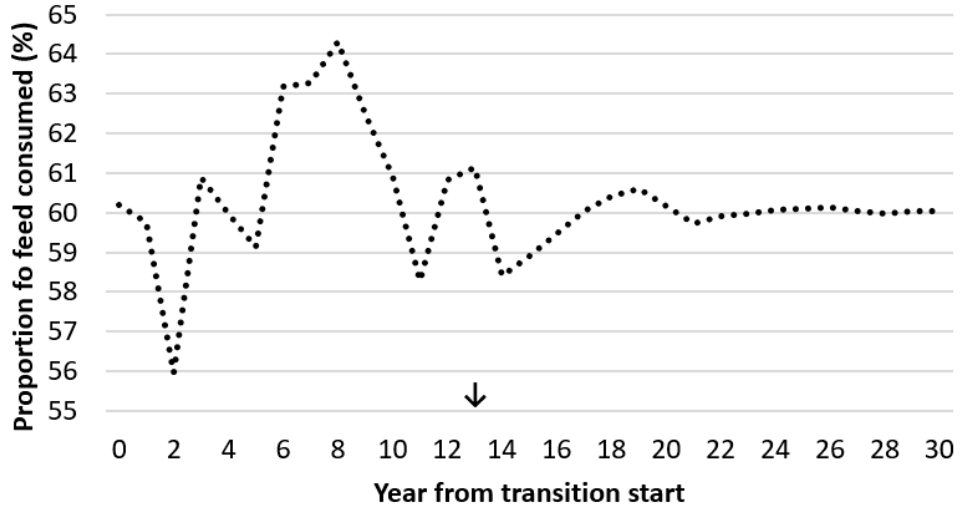
Figure 4. Total annual sheep feed demand as a proportion of farm feed supply during a grading up transition. Annual sheep feed demand was constrained between 55% and 65% of total farm feed supply, from a base level of 60% typical of East Coast North Island hill country farms [2]. ↓ indicates where the 3 / 4 Merino 1 / 4 Romney flock has reached the same annual feed demand as the base Romney flock.